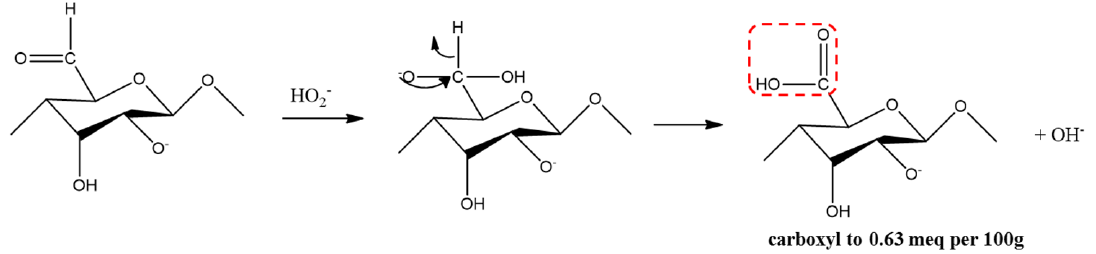
Figure 9. The oxidation to carboxylic acid.